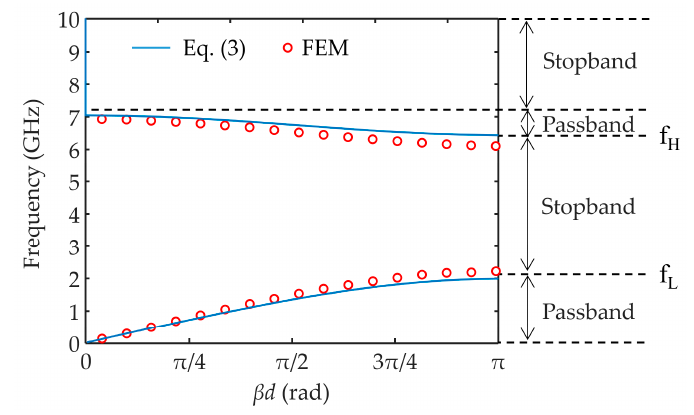
Figure 5. Dispersion diagrams of the CMS-EBG structure from Floquet-Bloch analysis.